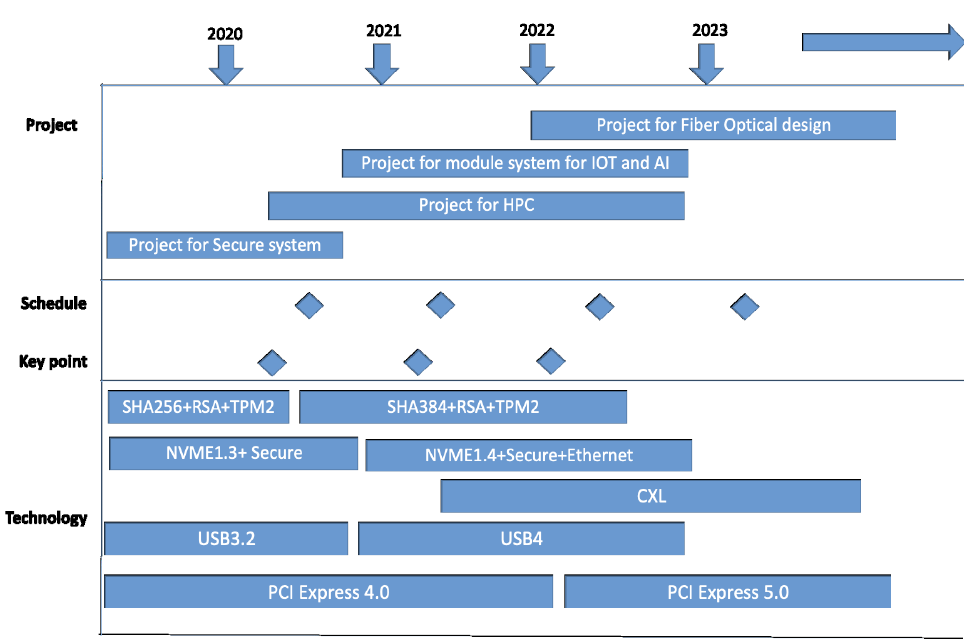
Figure 17. System design strategy for